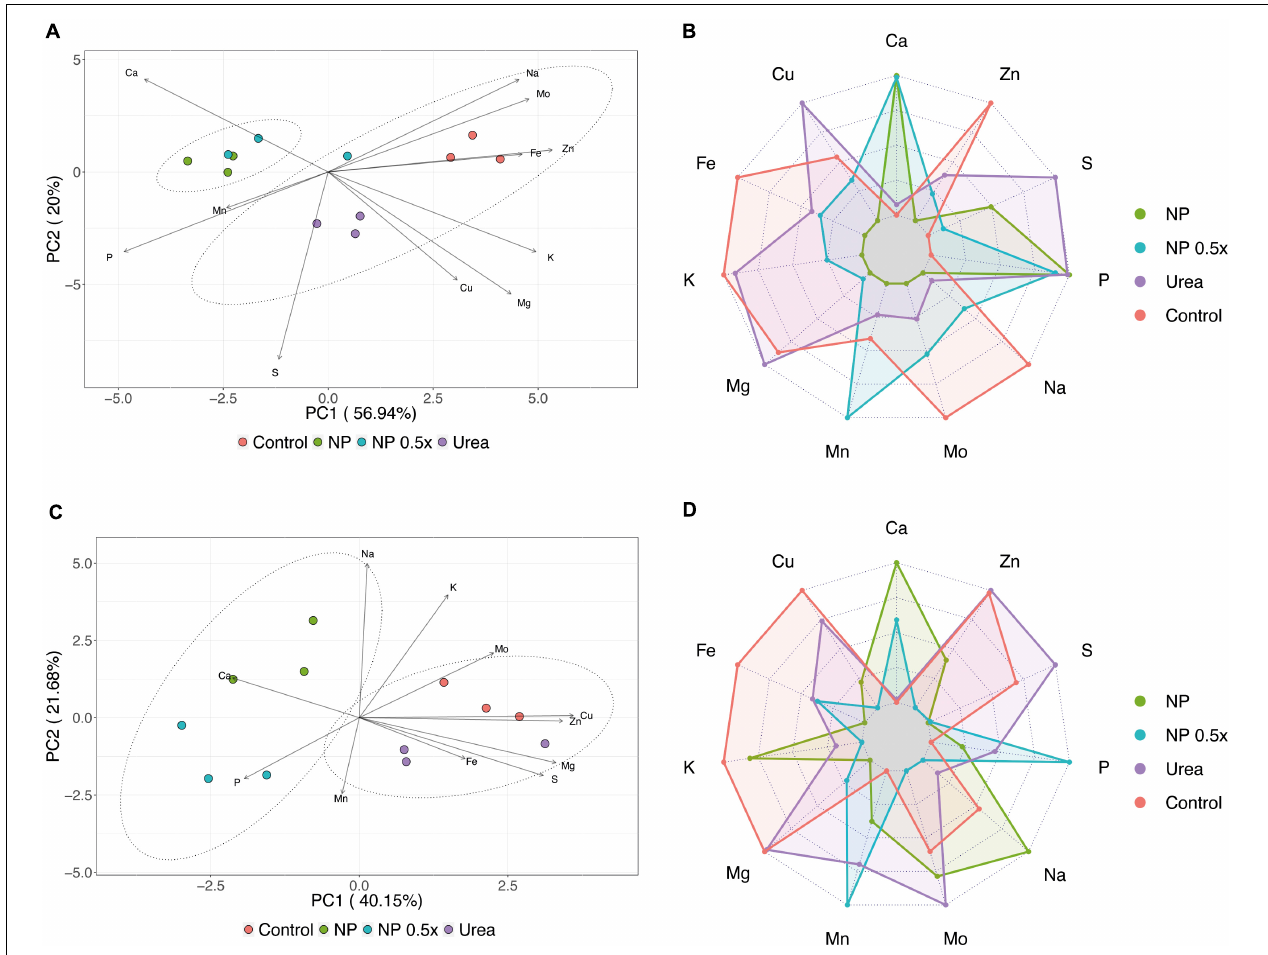
FIGURE 5 | Ionomic analysis. (A) Scatter plot reporting the results of the PCA carried out on root ionomic profile of cucumber plants either not treated (control) or supplied with 1 mM urea, NP, or NP.5 × . The assessments have been carried out at harvest (i.e., 7 days after the treatments as depicted in Supplementary Figure 2C ) on three independent biological replicates. The statistical significance of the difference between the two clusters drawn has been assessed by PERMANOVA analysis with 5,000 permutations ( p < 0.001). (B) Radar chart reporting the variations in element concentration in roots of cucumber plants supplied with 1 mM Urea, NP, or NP.5 × with respect to control plants. (C) Scatter plot reporting the results of the PCA carried out on shoot ionomic profile of cucumber plants either not treated (control) or supplied with 1 mM Urea, NP, or NP.5 × . The assessments have been carried out at harvest (i.e., 7 days after the treatments as depicted in Supplementary Figure 2C ) on three independent biological replicates. The statistical significance of the difference between the two clusters drawn has been assessed by PERMANOVA analysis with 5,000 permutations ( p < 0.001). (D) . Radar chart reporting the variations in element concentration in the shoot of cucumber plants supplied with 1 mM Urea, NP, or NP.5 × with respect to control